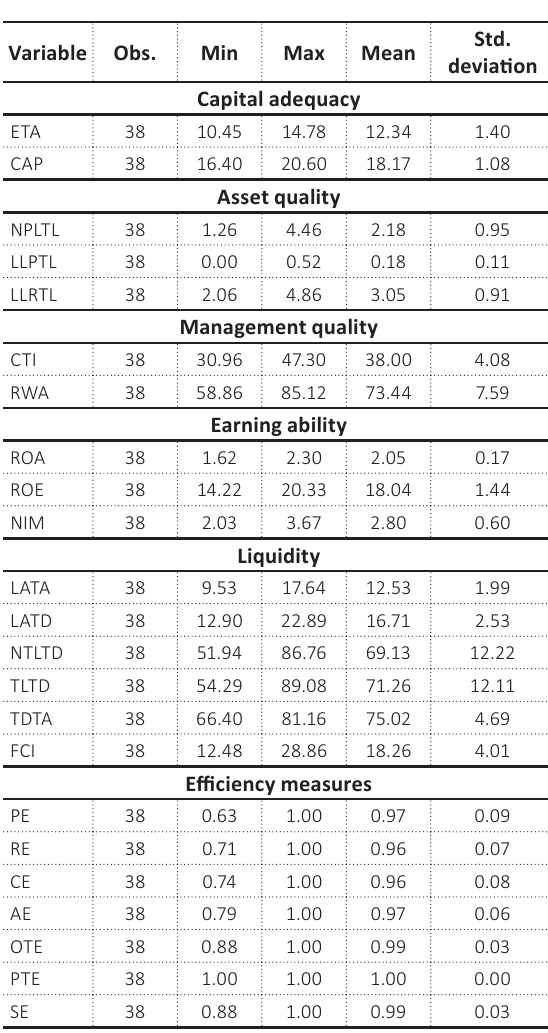
Figure 2. NCB’s assets, loans, and deposits from 2000 to 2018, USD billion Table 2. Descriptive statistics of all variables of the